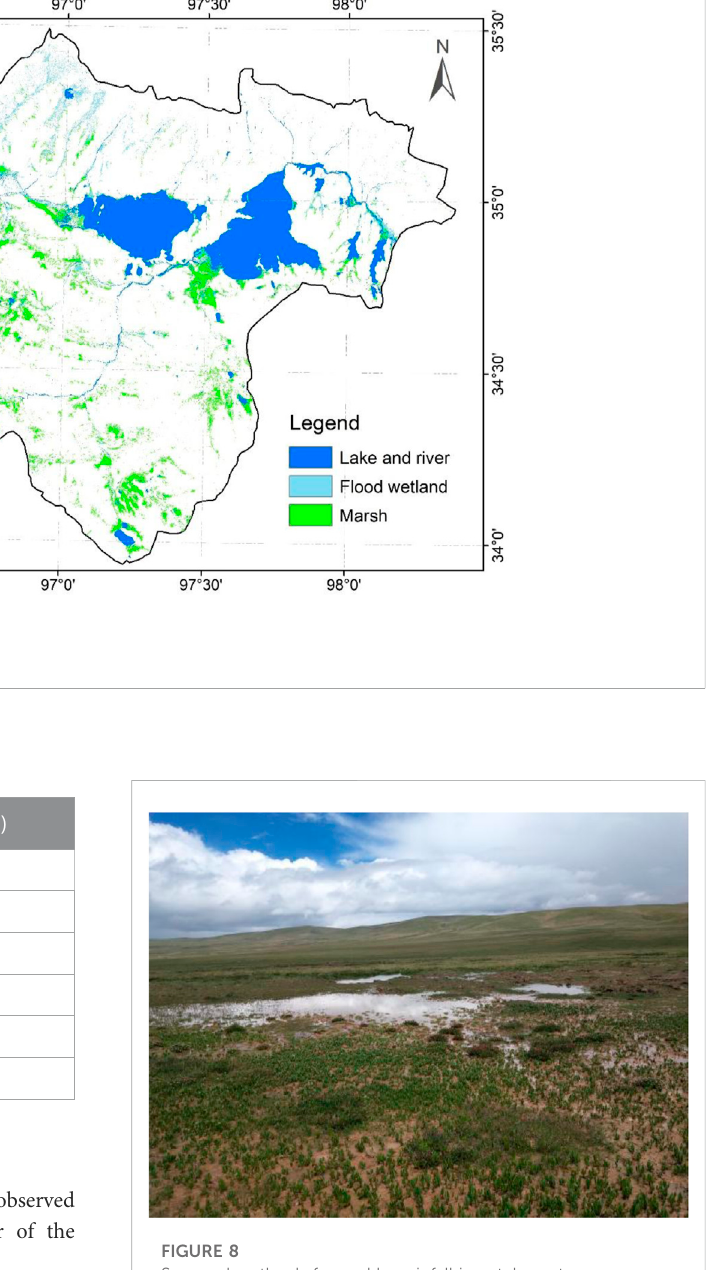
Seasonal wetlands formed by rainfall in catchment